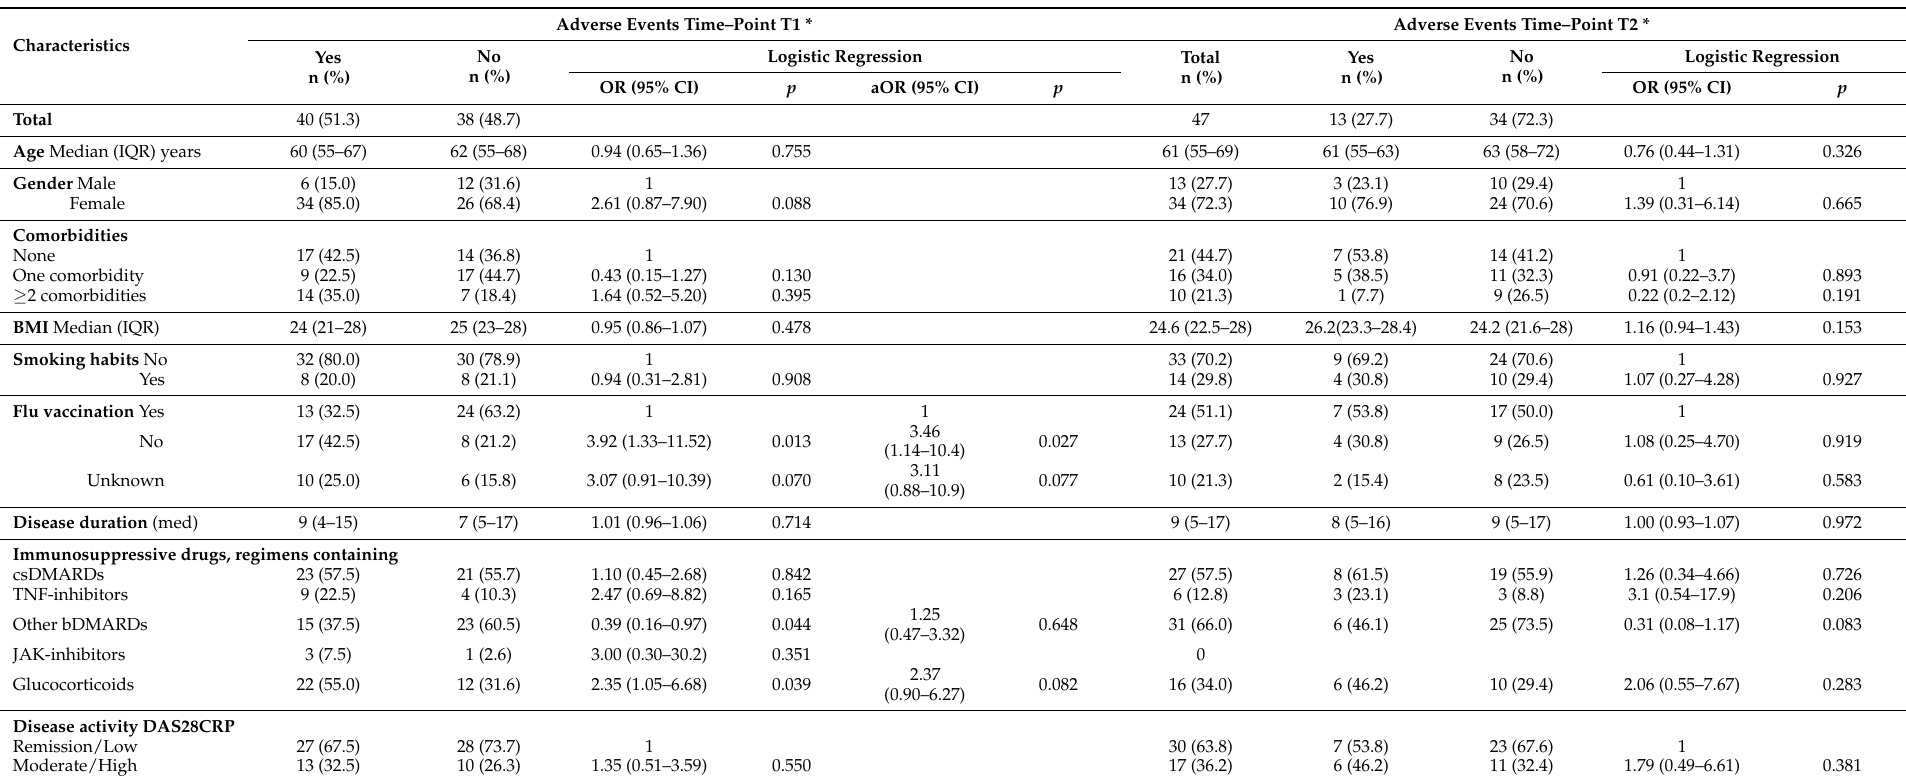
Table 2. Univariable and multivariable logistic regression of adverse events at T1 and T2 according to demographic and clinical